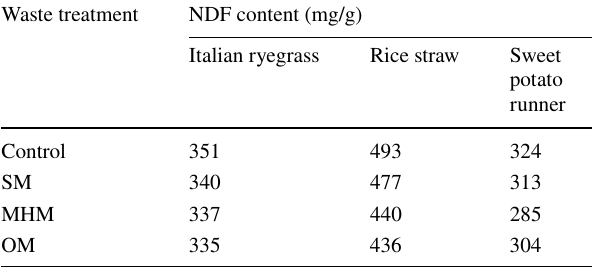
Table 2 NDF content in feedstuffs after treatment with enzyme prep- aration from shochu lees waste